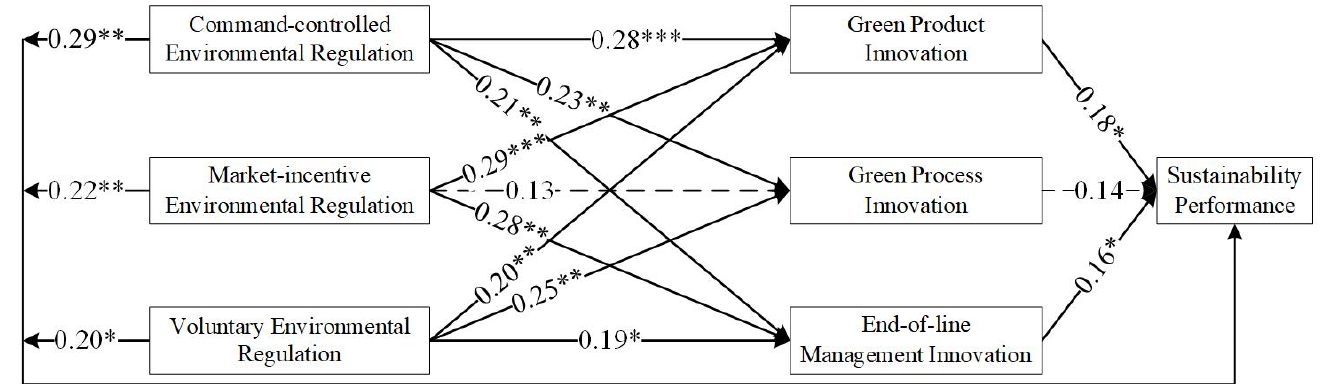
Figure 3. Results of the hypothesized model in East China. * denotes p < 0.05; ** denotes p < 0.01; *** denotes p < 0.001.